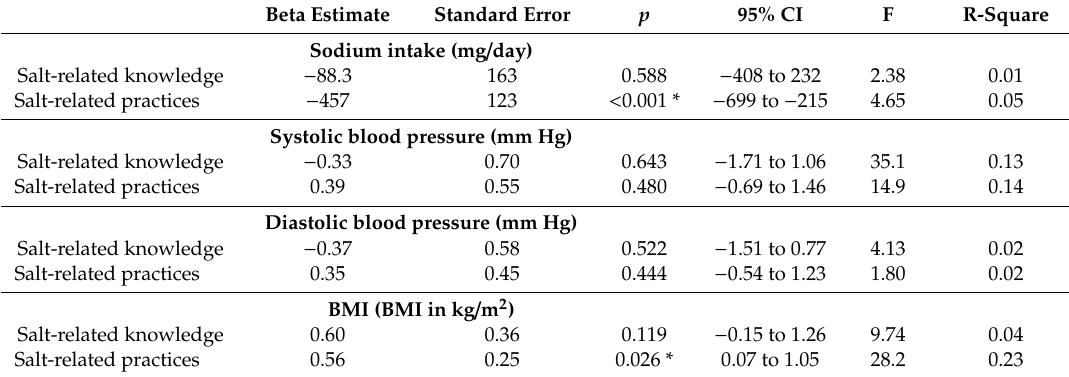
Table 4. Multiple linear regression analysis of salt-related knowledge and practice scores in relation to sodium intake, blood pressure, and body mass index